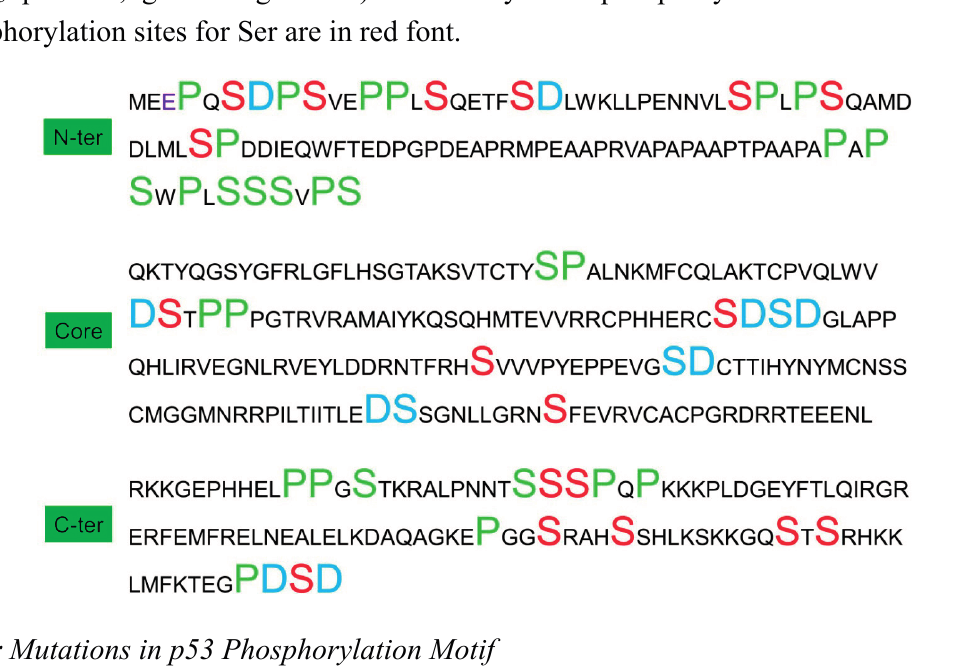
Y position, Blue large fonts) and P/S (in X i i+1